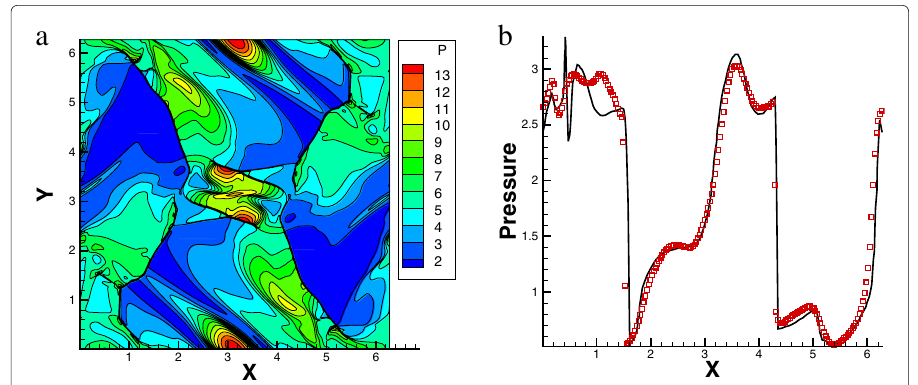
X Fig. 16 The UGKWP results of the multiscale Orszag-Tang vortex problem with Kn 10 4 and r 0 at t 3. Sub-figure ( a ) shows the UGKWP pressure contour, and sub-figure ( b ) shows the comparison of the UGKWP and MHD pressure distribution along y